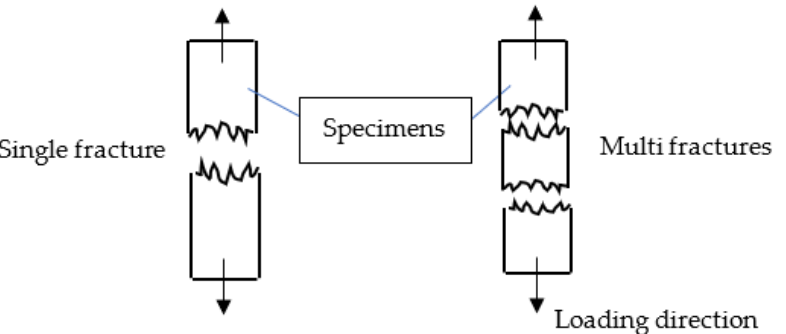
Figure 4. Single and multi-cross-sectional fractures.